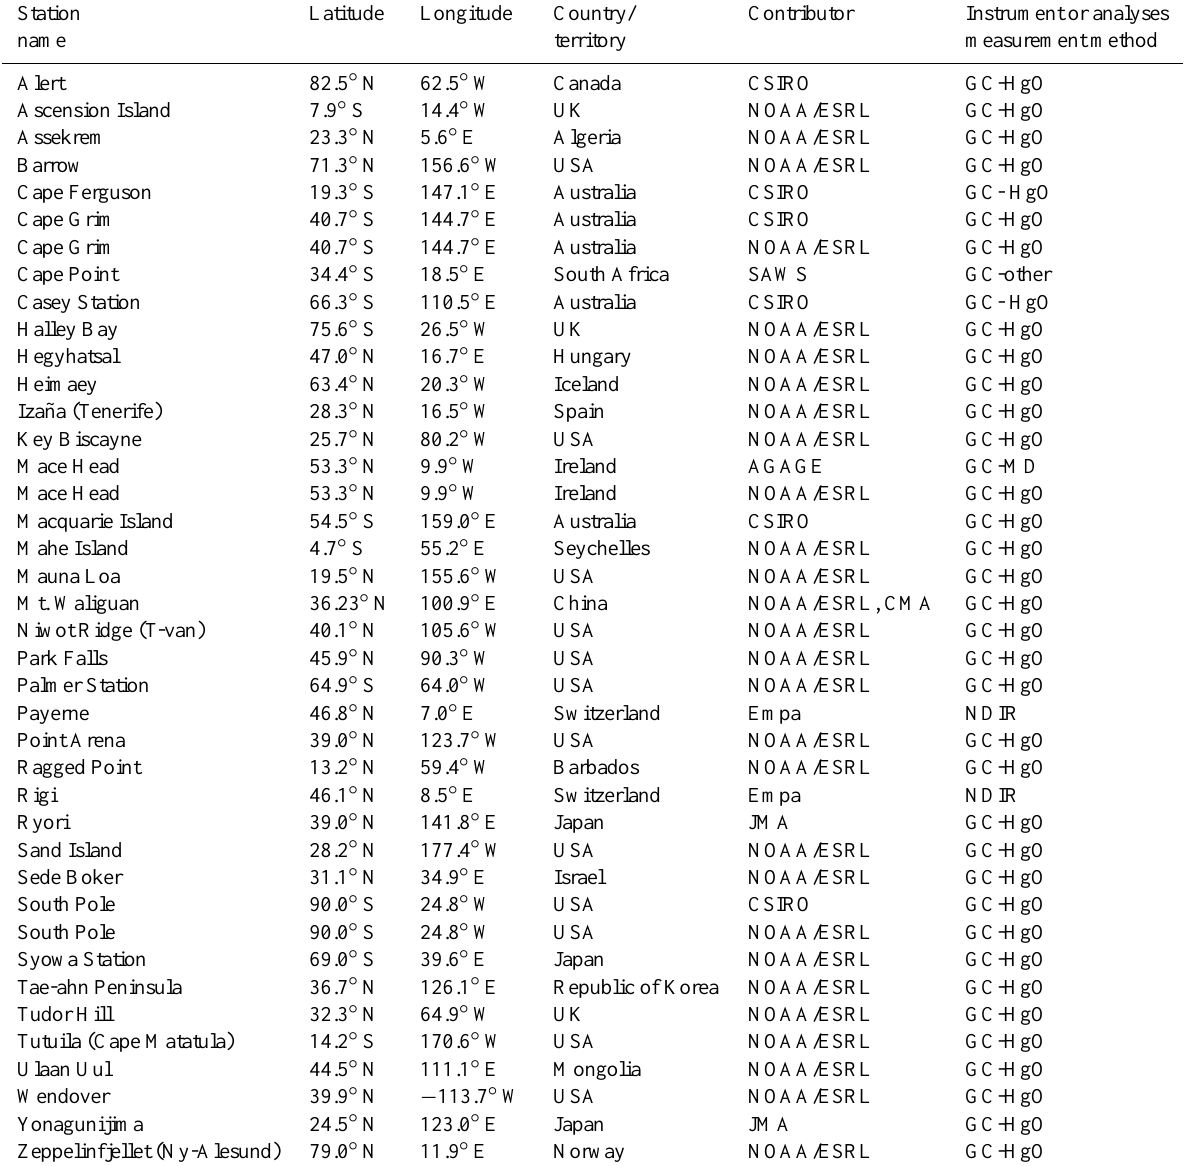
Table 2. WDCGG stations providing full 10-year monthly records of surface CO from 2001 to 2010. The WDCGG-archived data are used for the evaluation of trend estimates in this